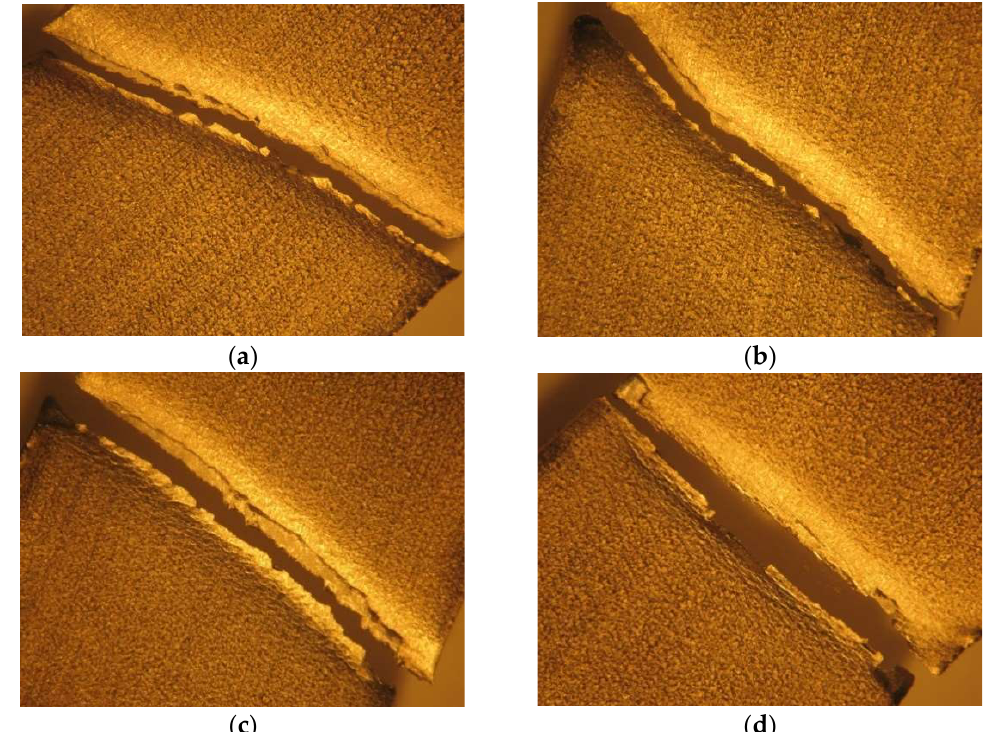
Figure 16. Detail of the fracture zone of the Duplex 14462 samples immersed in 5% NaClO and 100% NaClO for three weeks ( a , c ) and three months ( b , d ).